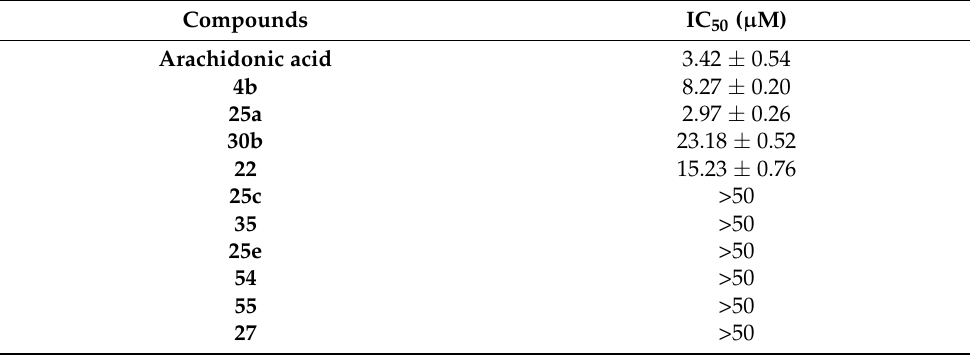
Figure 2. Single point displacement experiment for selected compounds. Table 3. Measured IC 50 values for selected compounds.